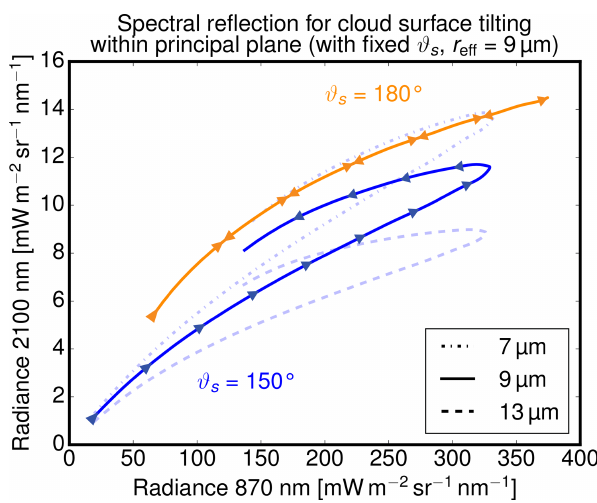
Figure 8. Spectral radiances used in two-wavelength retrievals at λ = 870nm and λ = 2100nm during the rotation of the cloud sur- face for observation geometries shown in Fig. 7. Calculations of spectral reflection were done for an optically thick ( τ = 500) wa- ter cloud with a fixed effective radius r eff = 9µm, a fixed scattering angle of ϑ s = 180 ◦ (orange line, 9µm), and three different effective radii with a fixed scattering angle of ϑ s = 150 ◦ (blue lines, 7, 9, and